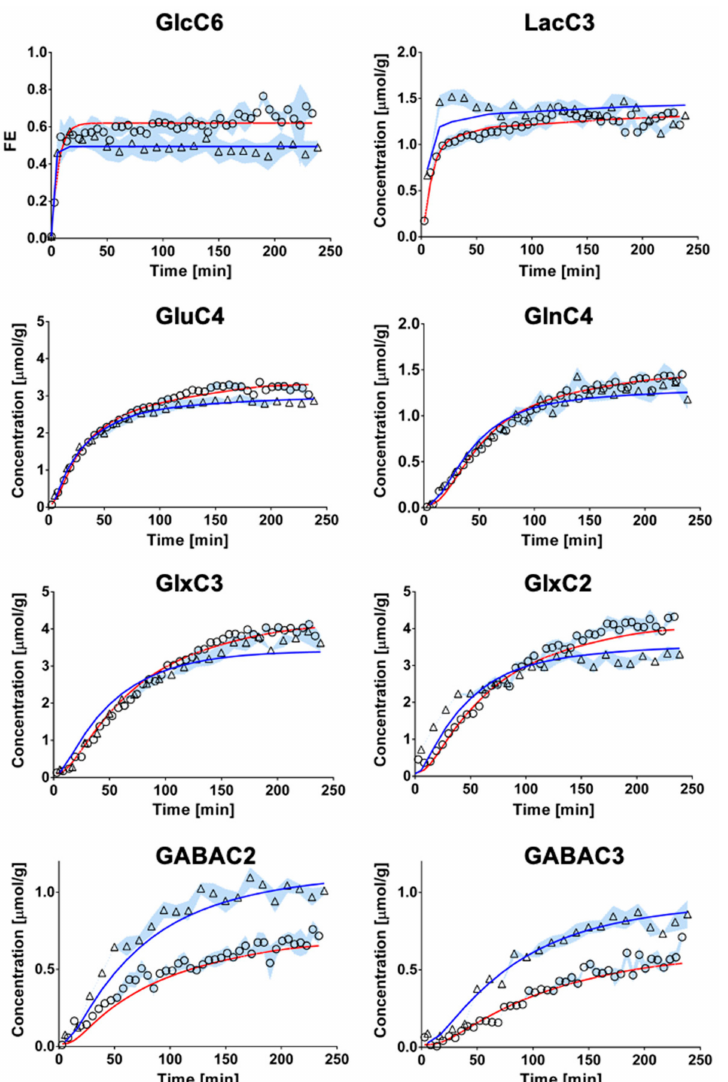
Figure 4. Fitting of the 1-compartment model of brain metabolism to hippocampal and hypothalamic metabolic 13 C-labeling curves. Hippocampal (circles) and hypothalamic (triangle) 13 C-labeling curves (mean ± SD) were analyzed with a 1-compartment model of brain metabolism. The resulting overall fit of hippocampus (red line) was comparable to that of hypothalamus (blue line) in terms of goodness-of-fit (hippocampus, R 2 = 0.994; hypothalamus, R 2 =